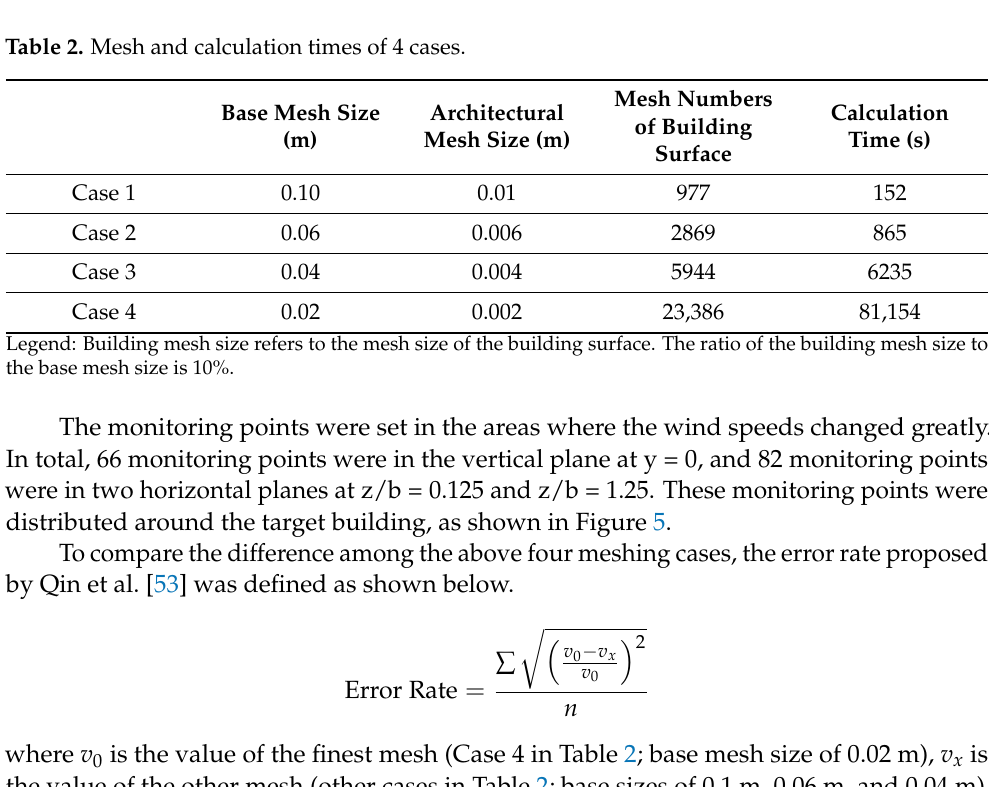
Table 2. Mesh and calculation times of 4